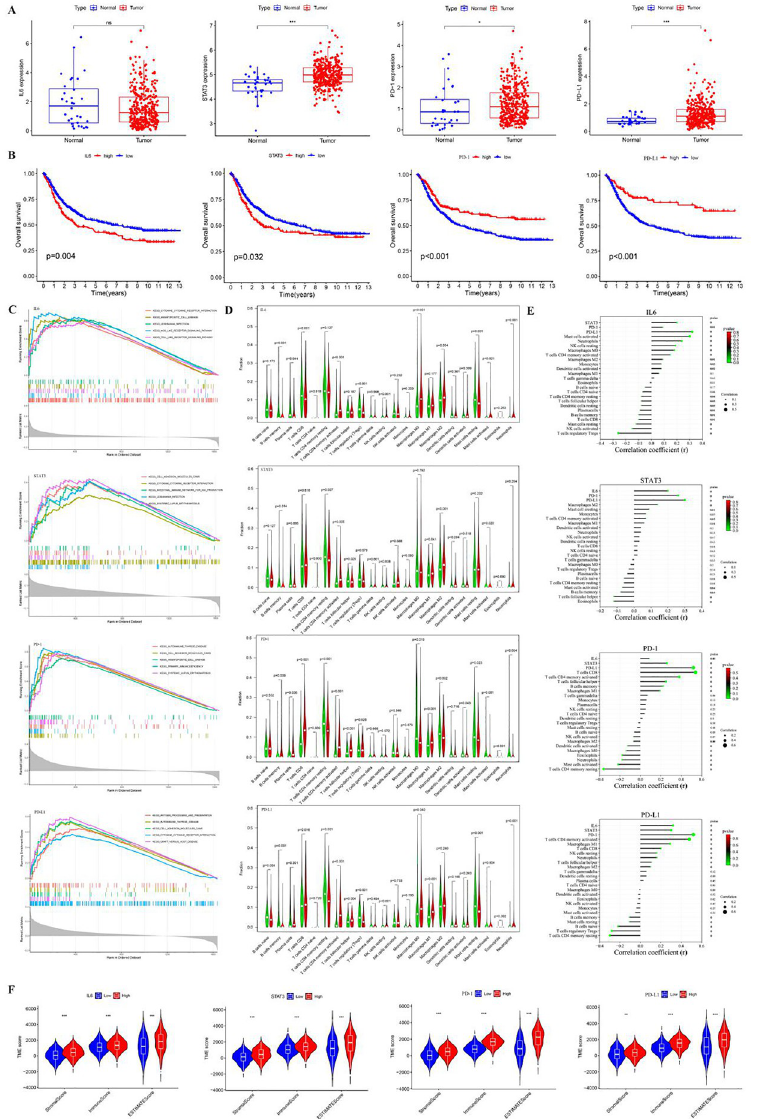
Fig 6. The expression of IL-6, Stat3, PD-1 and PD-L1 and their relationship with tumor immunity in TCGA and GEO combined gastric cancer datasets. The mRNA expression of STAT3/IL6/PD-1/PD-L1 and corresponding median of GC patients to classify the high-low rating group. (A) Expression levels of IL6, STAT3, PD-1 and PD-L1 between tumor and normal tissues of gastric cancer patients in TCGA database. (B) Kaplan-Meier curves for STAT3, IL6, PD-1 and PD-L1 expression in low- and high-risk groups of patients. (C) The merged enrichment plots of STAT3, IL6, PD-1 and PD-L1 from gene set enrichment analysis including enrichment score and gene sets. (D) Violin plots (Wilcoxlog-rank test) of the differences in 22 immune cell fractions between the high and low expression groups of STAT3, IL6, PD-1 and PD-L1. (E) The Correlation between immune checkpoint genes and immune components. (F) Correlation of STAT3, IL6, PD-1 and PD-L1 expression with TME (the immune score, stromal score, and ESTIMATE score). � P < 0.05, �� P < 0.01, ��� P < 0.001.